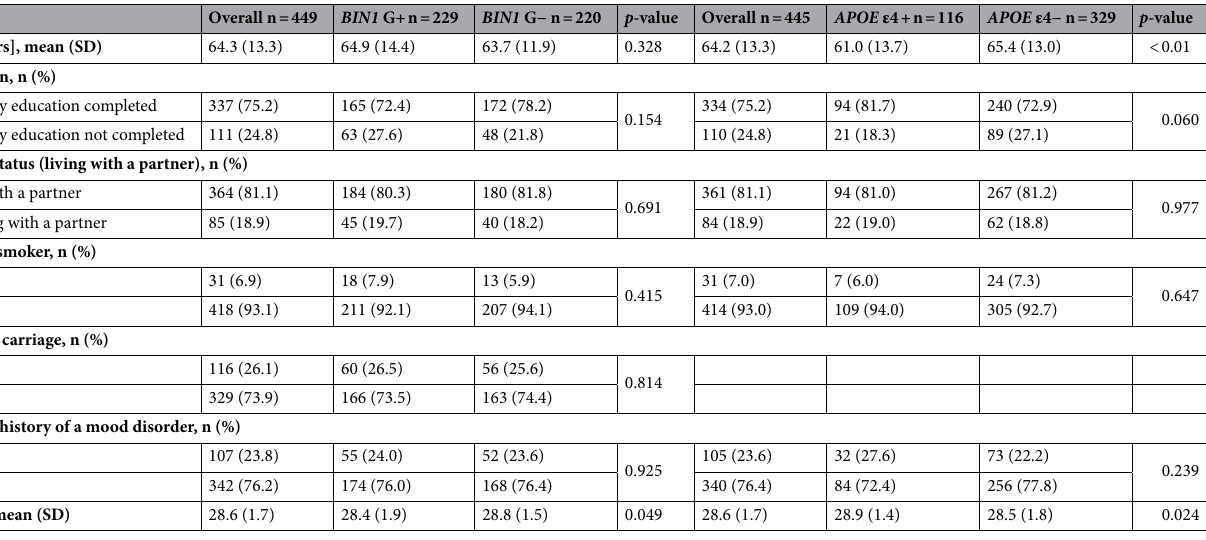
Table 1. Demographic characteristics of the study participants. Data are presented as mean (SD) or n(%).